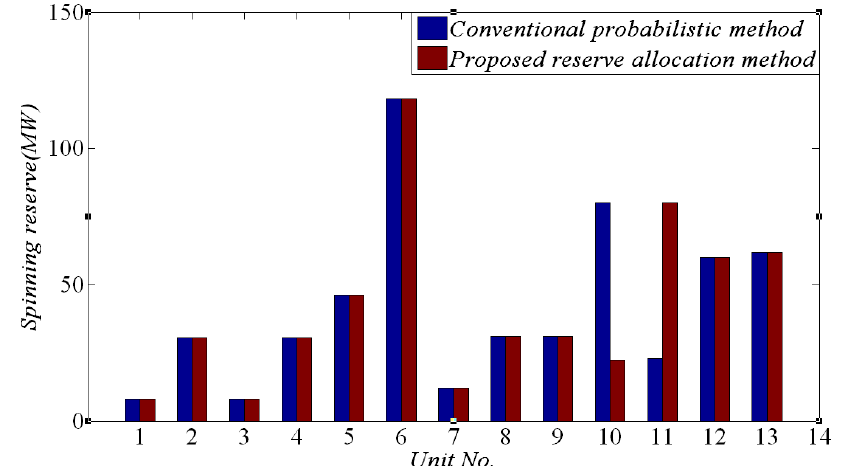
Figure 13. Spinning reserve capacities of all the units in the